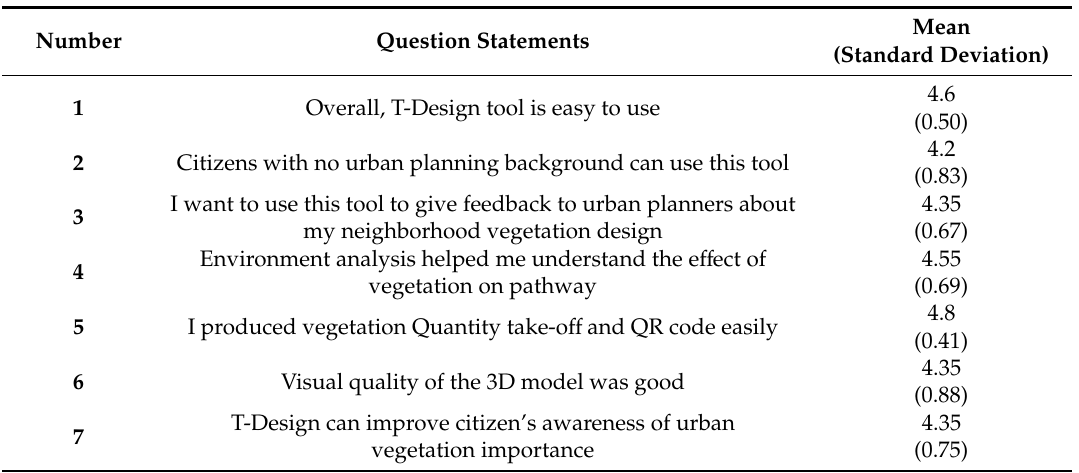
Table 5. Means and standard deviation of scores for dependent variables by the T-Design